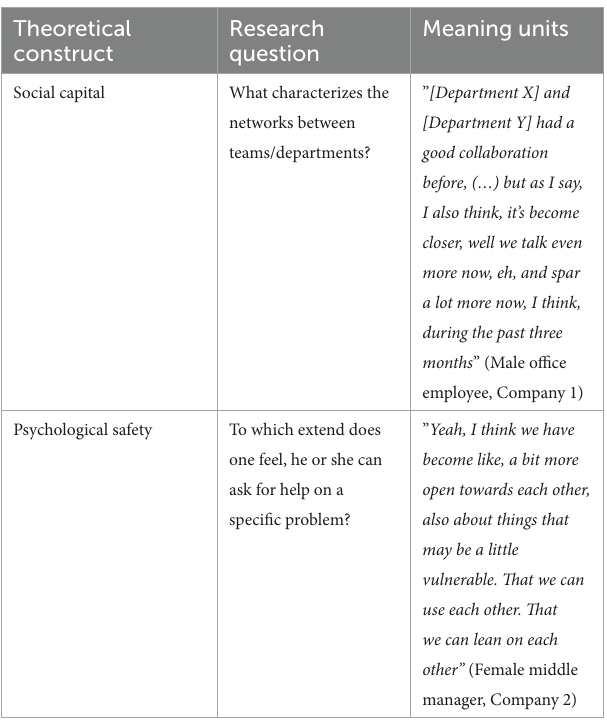
TABLE 4 Examples of the use of research questions from the categorization matrices to identify and extract meaning